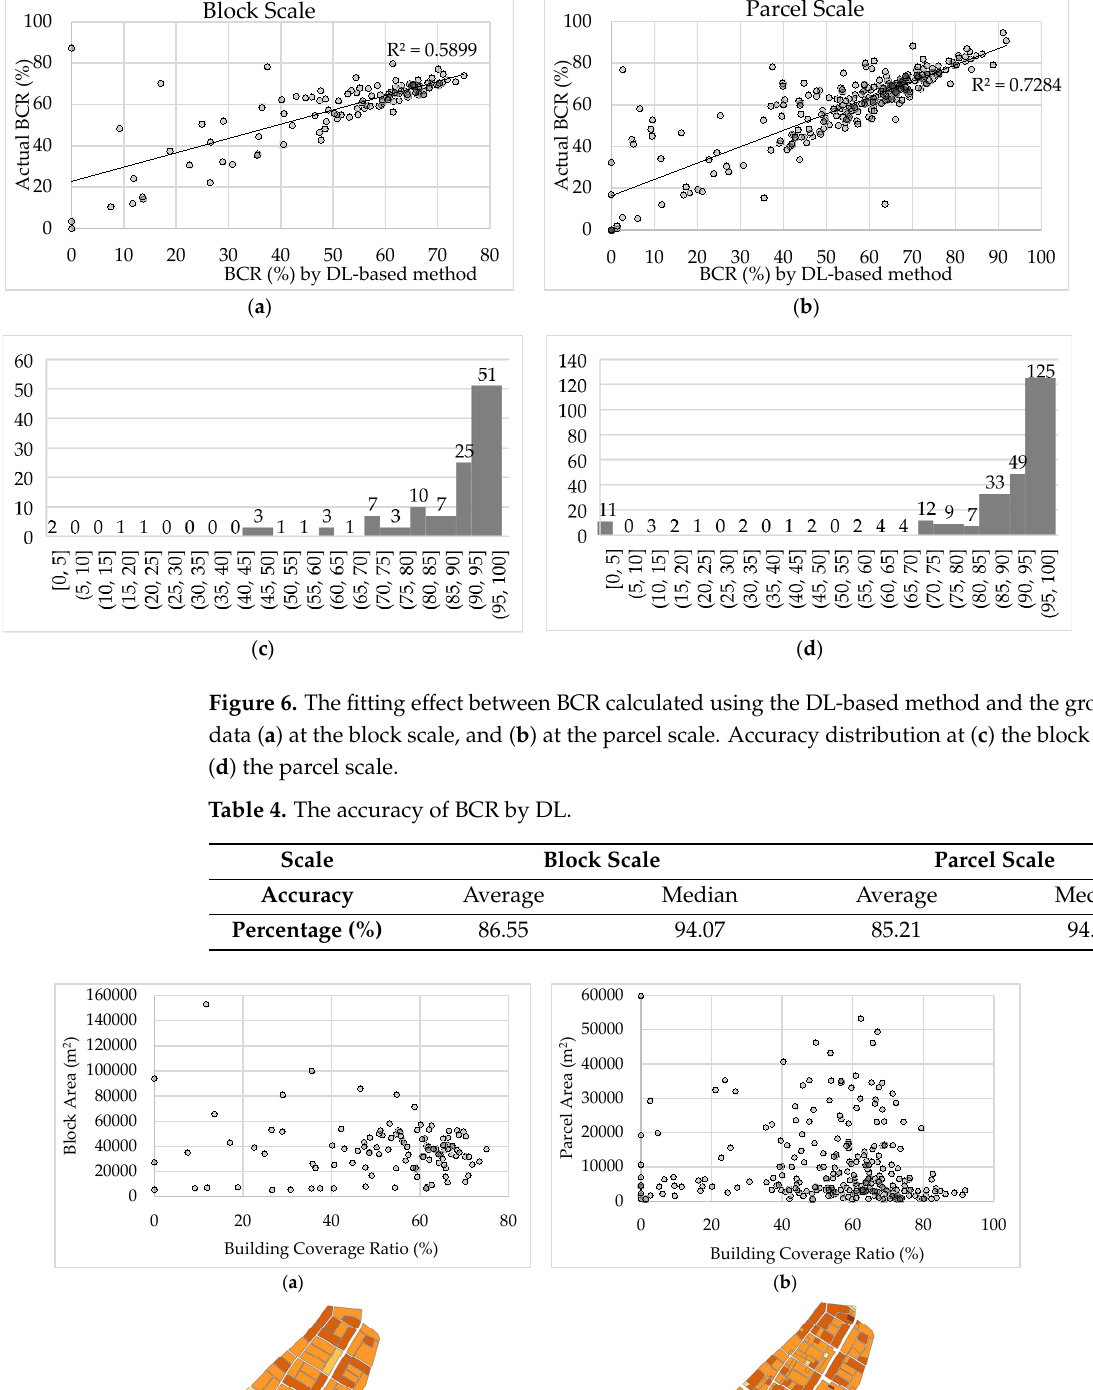
( b ) Figure 5. ( a ) The actual segmentation results plotted against the ground truth label, and ( b ) regular ‐ ized building footprints overlaid on top of a sample area from validation dataset. The BCR was calculated for each parcel and block in the referenced area based on the extracted building footprints. Then, the result was compared with the actual BCRs from the ground truth dataset to validate the accuracy of DL ‐ based method. In order to identify the correlation between the two variables, the BCRs at both the block scale and parcel scale were plotted on scatter charts to highlight the relationship (Figure 6a,b). The R 2 values off 0.5899 and 0.7284, respectively, for the block scale and the parcel scale, although there are some outlier points where a calculated BCR value is either much larger or much smaller than that for the actual data. The outliers in the BCRs at the block scale were significantly greater than those at the parcel scale, leading to a considerably lower R 2 value. The outliers were mainly located in the low ‐ density blocks with building densities below 20%; the fit ‐ ting for the dense blocks was generally much better. Unlike the block scale, the pattern in